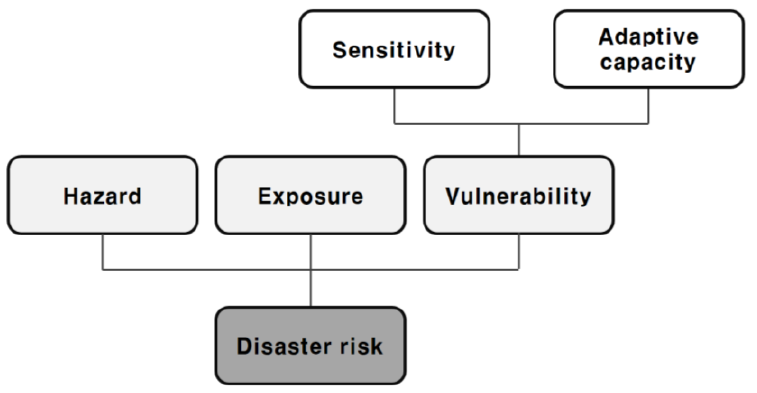
Figure 3. Flow chart of disaster risk framework [29].